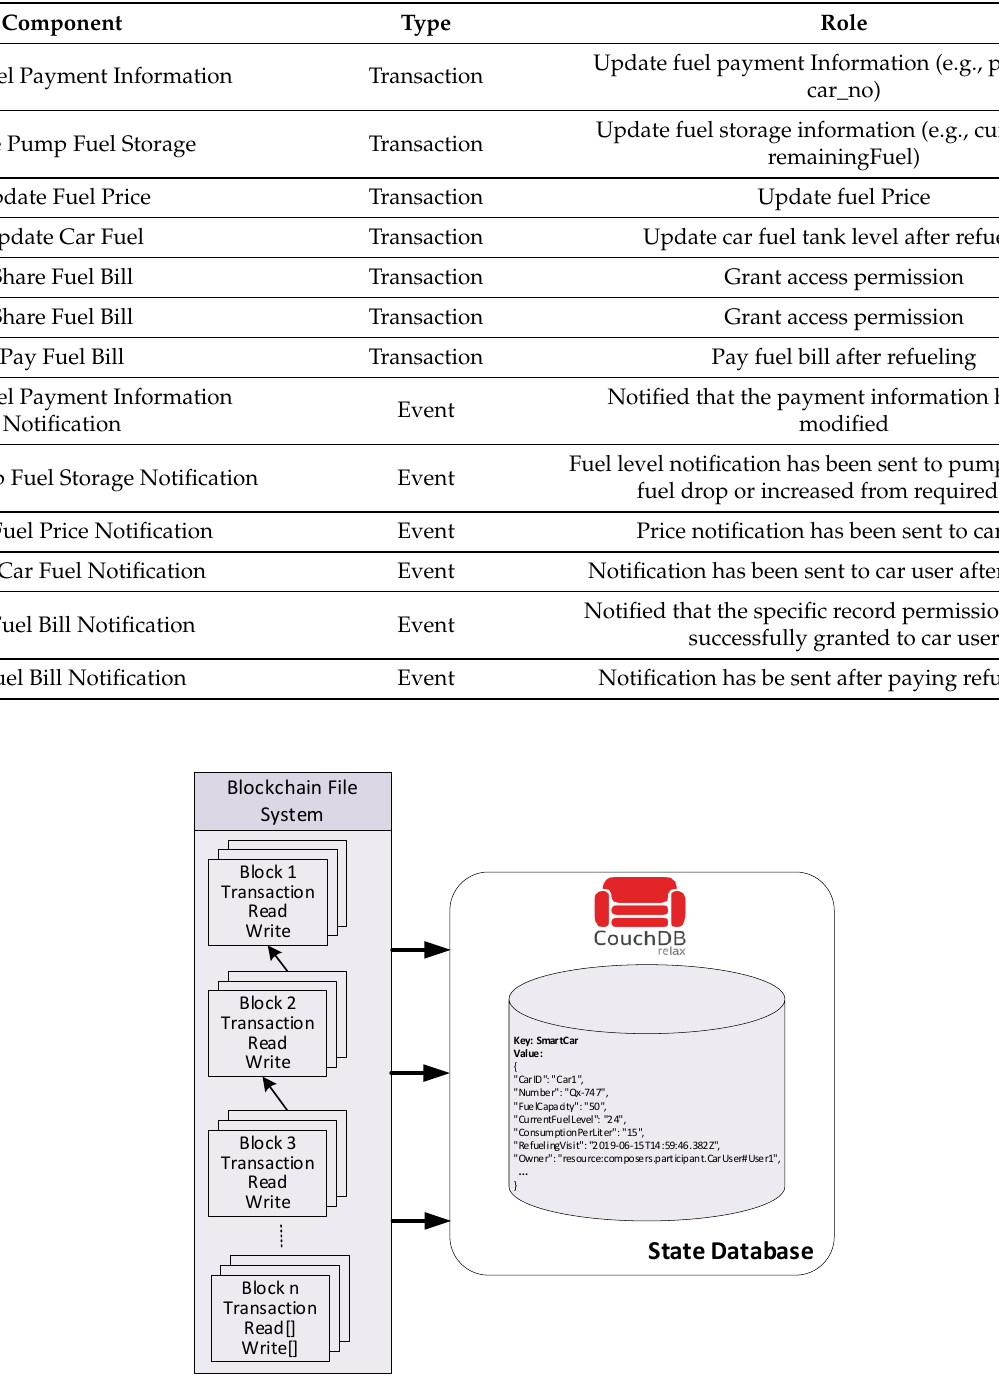
Table 3. Transaction and event definition of the proposed blockchain platform.